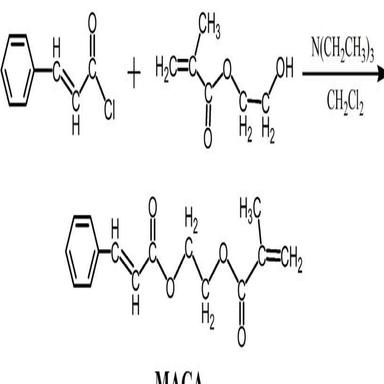
Synthetic route for the monomer, methacryloxyvinyl cinnamate (MACA).